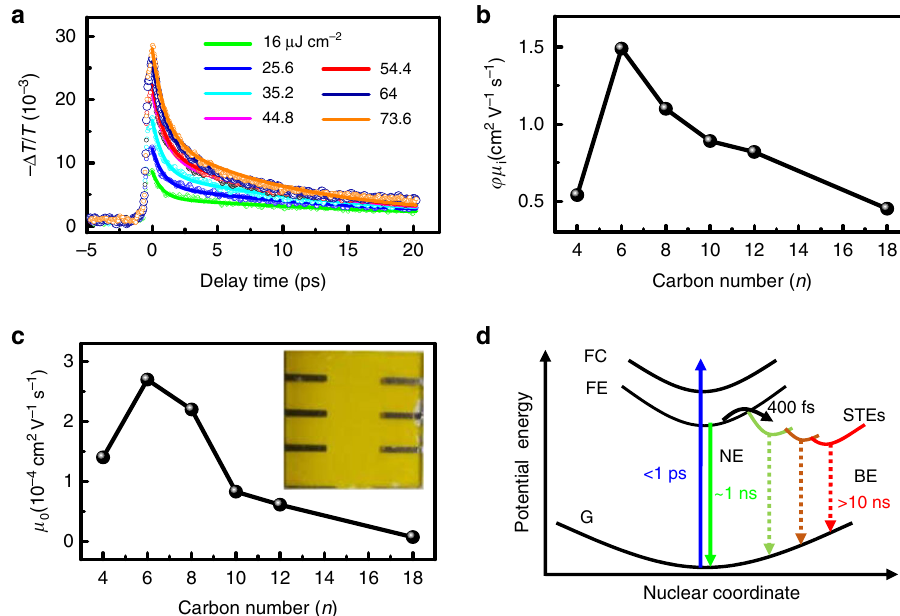
Fig. 1 Charge-carrier mobility determined by OPTPS measurements and current-voltage (I – V) measurements. a Representative transient THz transmission changes, Δ T/T, of HA 2 PbI 4 ( n = 6) for different excitation fl uences ( λ pump = 400nm). Symbols represent experimental data while solid lines are fi tting to the data using biexponential function. b Effective charge-carrier mobility along the fi lm plane ( φμ i ) determined by OPTPS with the pump – Gurney analysis of the I – V data curves. Inset shows a picture of fl uence of 25.6 μ J cm − 2 . c Out-of-plane charge-carrier mobility ( μ o ) determined by Mott the devices/ fi lms. d Schematic of the adiabatic potential energy curves of the ground state (G), free-exciton state (FE), free-carrier state (FC), and various self-trapped excited states (STEs). The vertical dashed line shows possible nonradiative decay processes of the FE and